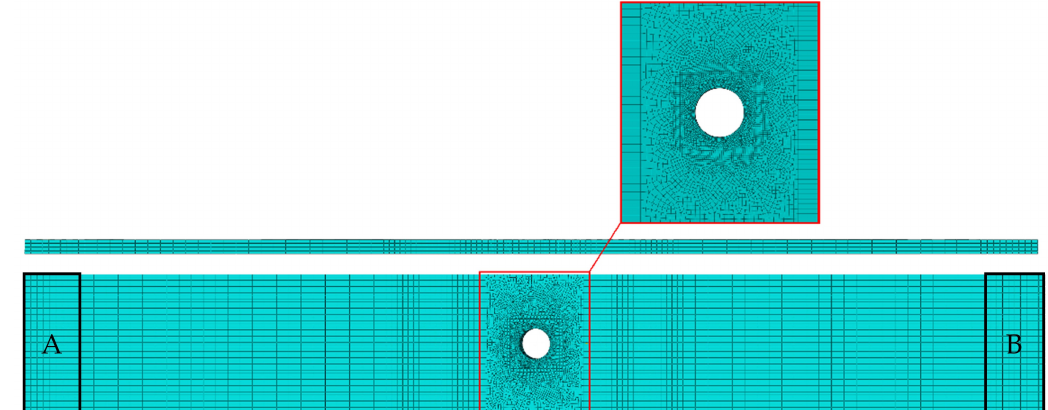
Figure 3. Finite element mesh used in the numerical